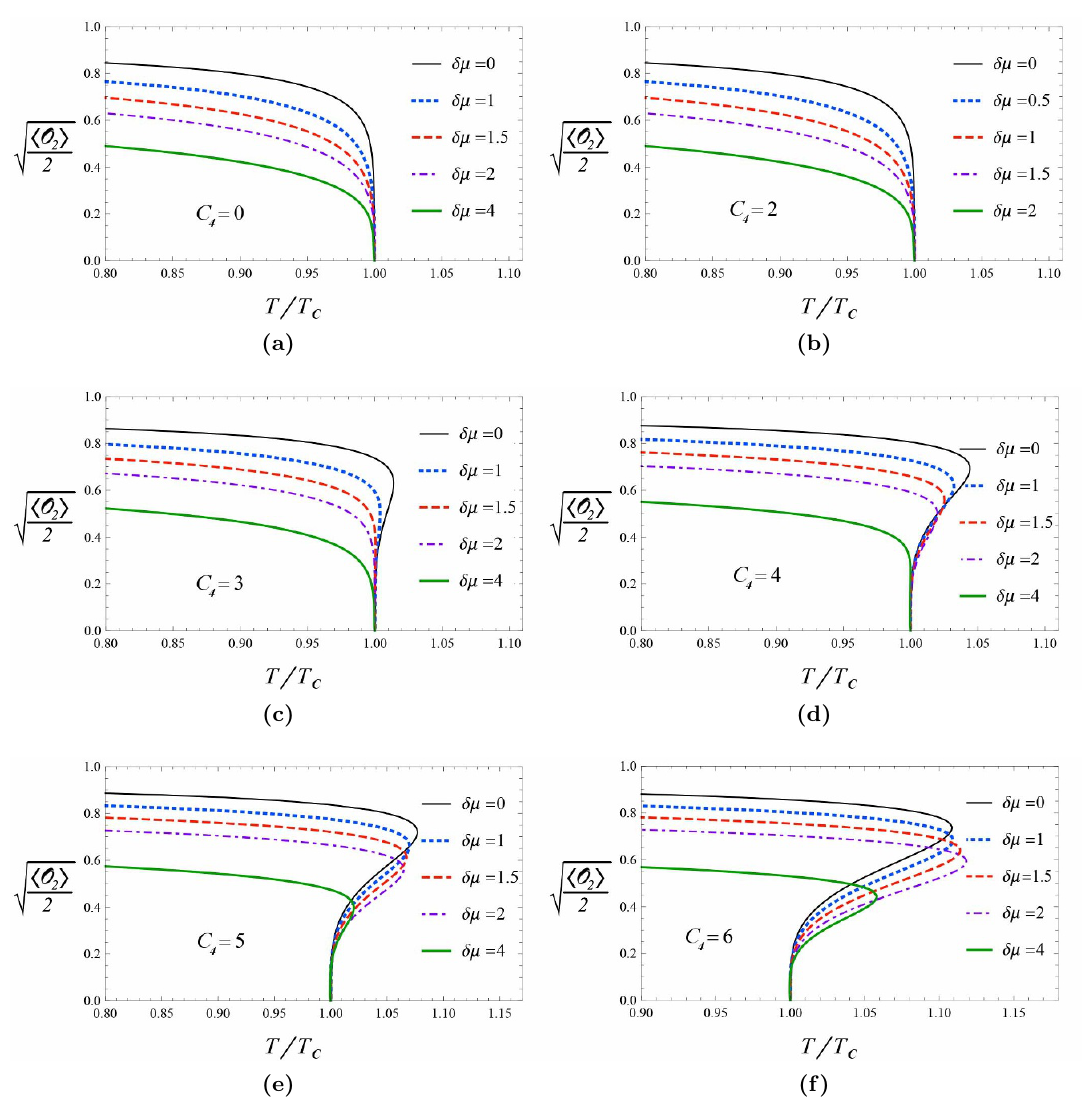
Figure 4. Value of condensation as a function of temperature for function F ( ) = 2 + C 4 4 with C 4 = 0 ; 2 ; 3 ; 4 ; 5 ; 6 and (cid:14)(cid:22) = 0 ; 0 : 5 ; 1 ; 1 : 5 ;